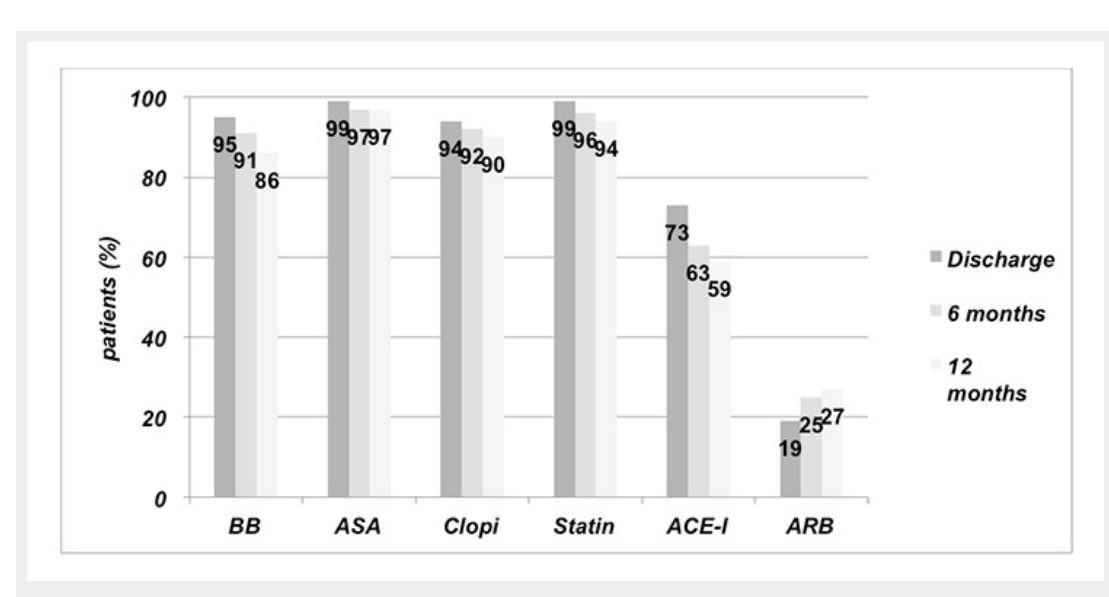
Figure 1 Secondary prevention medication after myocardial infarction (n = 204) at hospital discharge, and 6 and 12 months after discharge. ACE-I = angiotensin-converting enzyme inhibitor; ARB = angiotensin receptor blocker; ASA = acetylsalicylic acid; BB = beta-blocker; clopi =